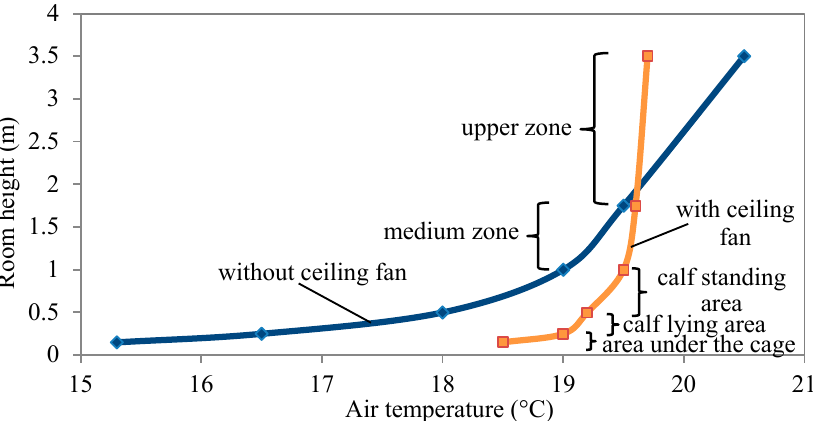
Figure 5. Air temperature distribution, in preventive maintenance premises for calves.